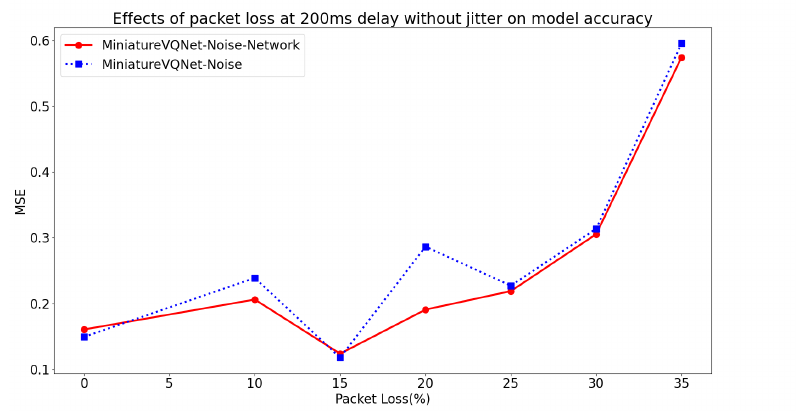
Figure 8. Effect of packet loss on prediction accuracy.